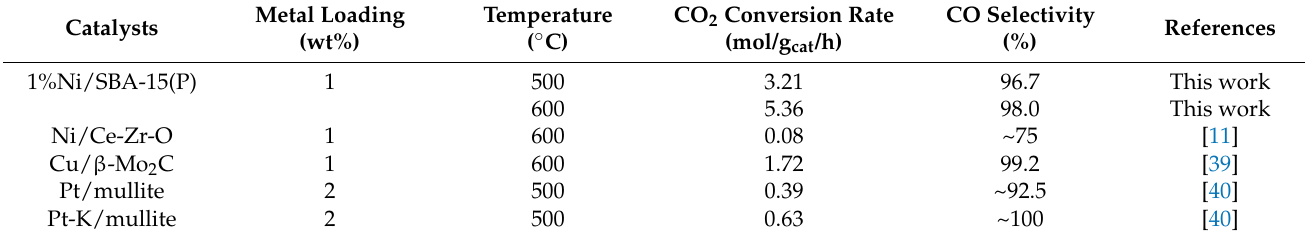
Figure 6. The catalytic stability of the 1%Ni/SBA-15(P) catalyst at 700 ◦ C: ( a ) CO 2 conversion, ( b ) CO selectivity. Table 2. CO 2 conversion rate and CO selectivity of 1%Ni/SBA-15(P) and reported RWGS catalysts in References.